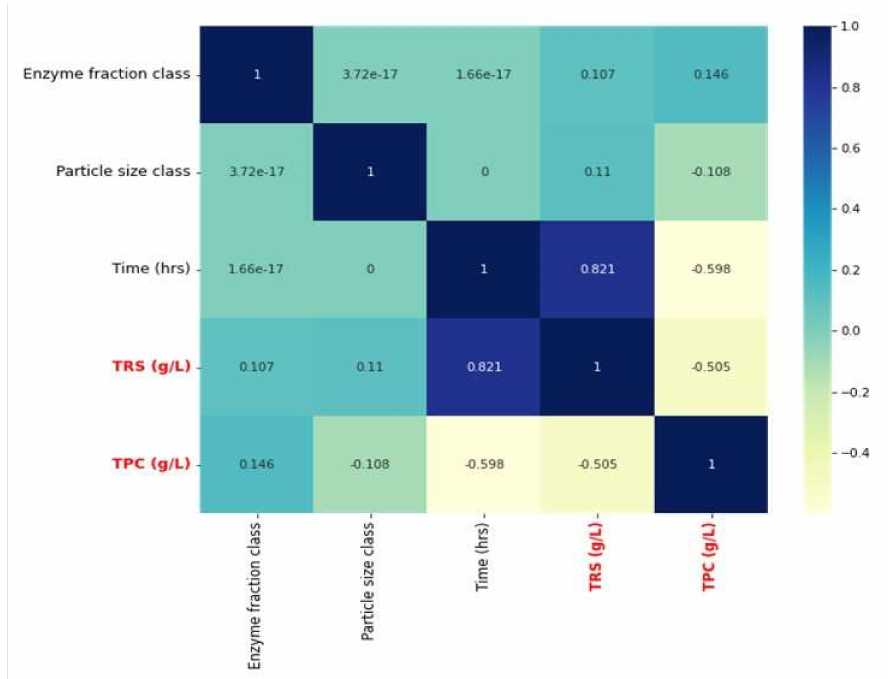
Figure 2. Correlation matrix between the amendable parameters for TRSs and TPCs